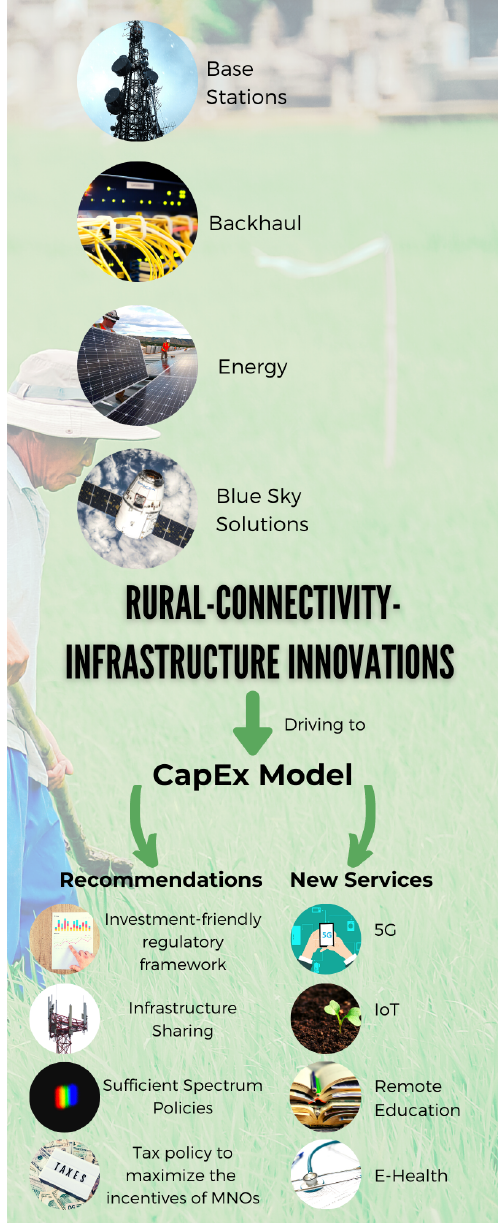
Figure 5. Innovations for rural